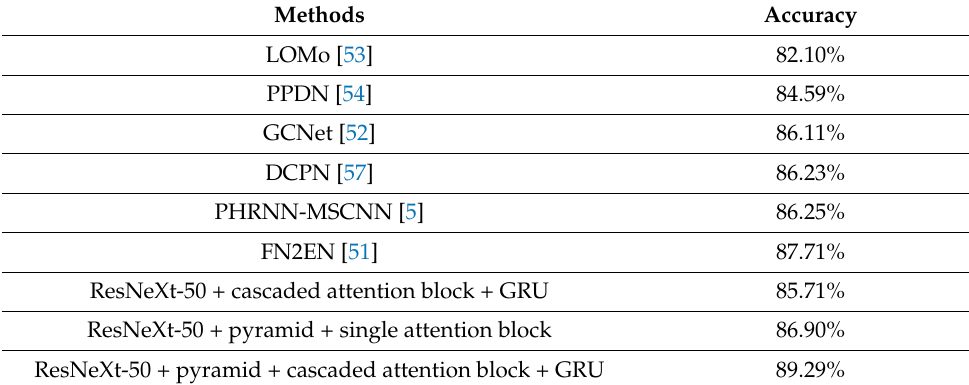
Table 3. Comparison on the Oulu–CASIA dataset.